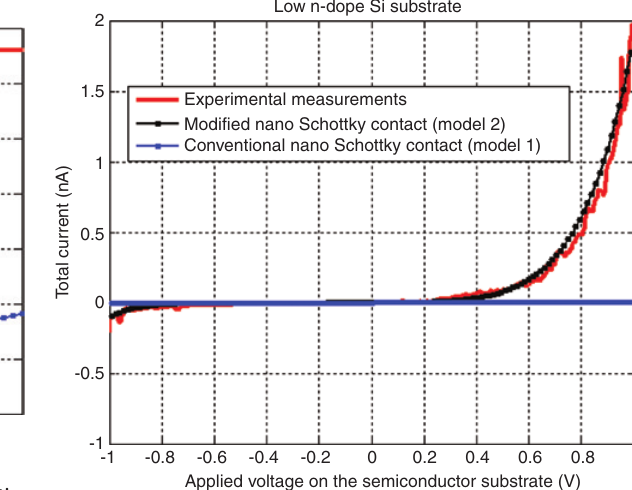
Figure 10: I-V data of the nano-Schottky junction between a nanotip and a low n-doped semiconductor substrate.